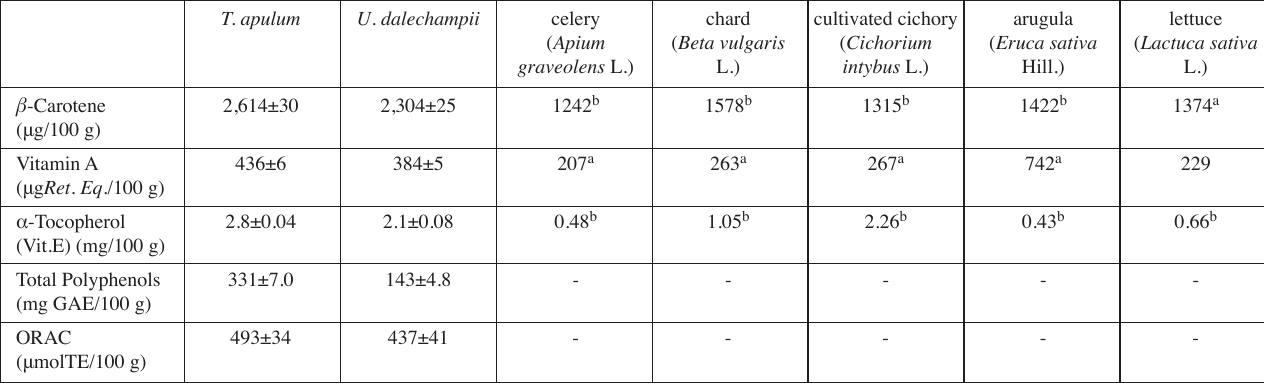
Tab. 2: β -carotene, vitamin E, total polyphenol content and ORAC values in 100 g of the edible parts of the two wild plants analyzed